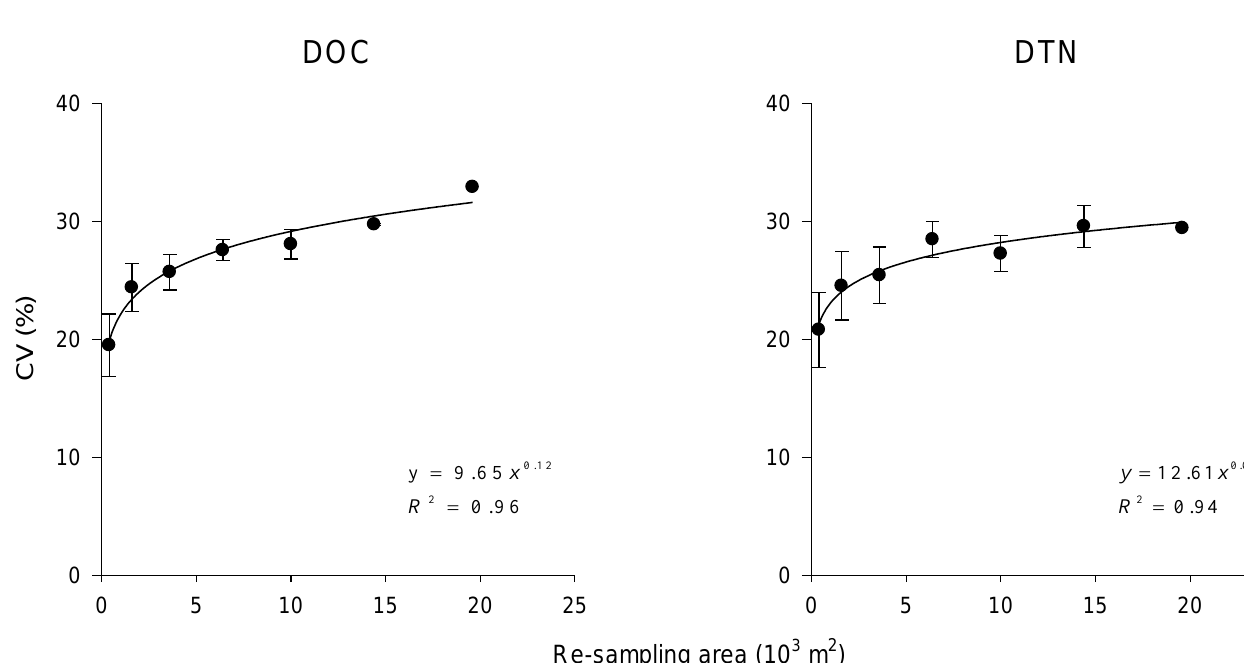
Figure 2. Relationship between the CV of DOC and DTN with increasing sampling area. Error bars represent the standard error of the mean. Table 3. Parameters of semi-variogram models for DOC and DTN. Nugget: the undetectable measurement error, inherent variability, or variation within the minimum sampling distance. Sill: total variation. Nugget sill ratio: the degree of spatial variability. RSS: residual sum of